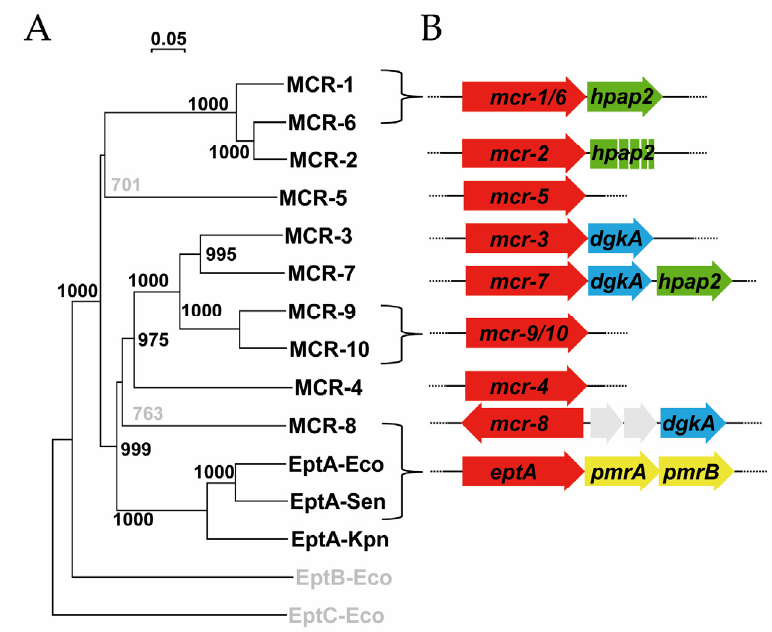
Figure 1. Phylogenetic relationships of plasmid-mediated colistin resistance (MCR / PmrC) proteins and clustering of their coding sequences with linked genes. ( A ) Protein sequence alignment and phylogenetic tree were generated using Clustal X 2.0 and NJPlot 2.3 (neighbor-joining algorithm and correction for multiple substitutions). Bootstrap values are indicated and assumed to support the branching of a clade when they are higher than 70% [12], whereas the scale bar represents the genetic distance (0.2 = 20%). Sequences represented are as follows: MCR-1, A0A0R6L508.1; MCR-2, WP_065419574;